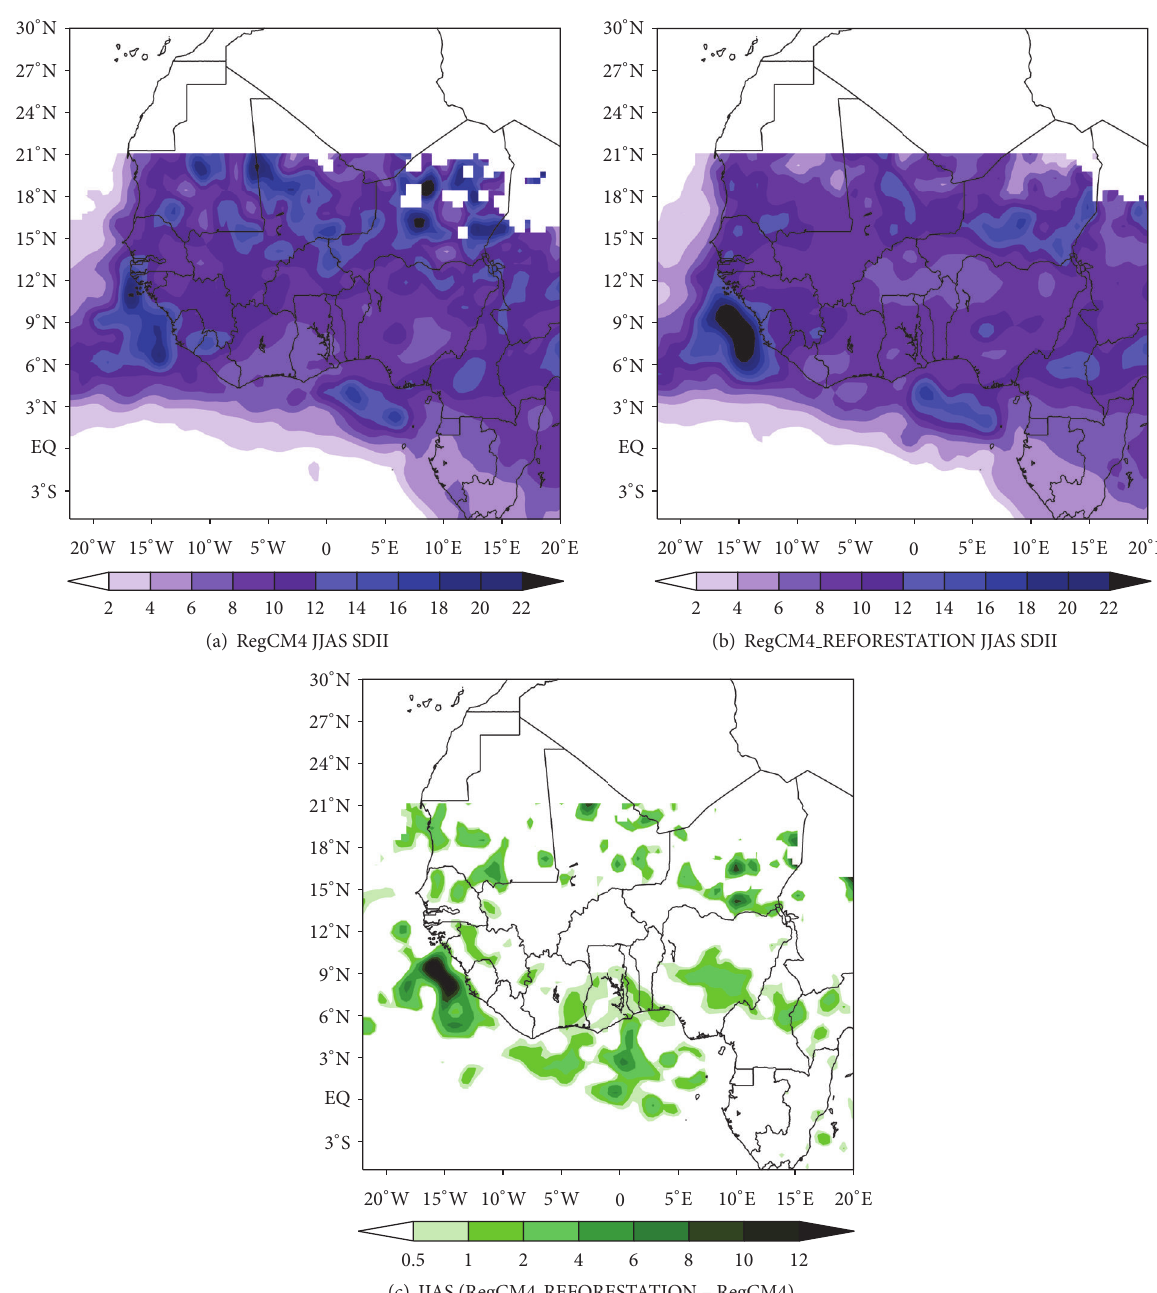
Figure 9: Mean summer simple daily intensity index (mm/day) for both runs and their difference averaged from 2003 to 2009.